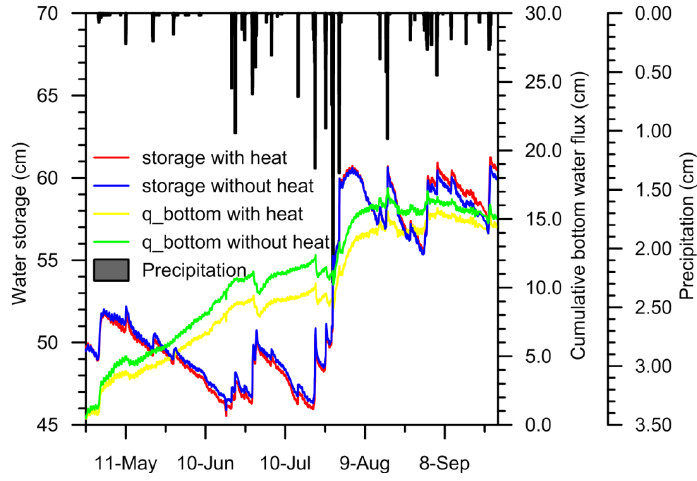
Figure 9. A comparison of the cumulative change in soil water storage and cumulative bottom water flux, both with and without heat flow.